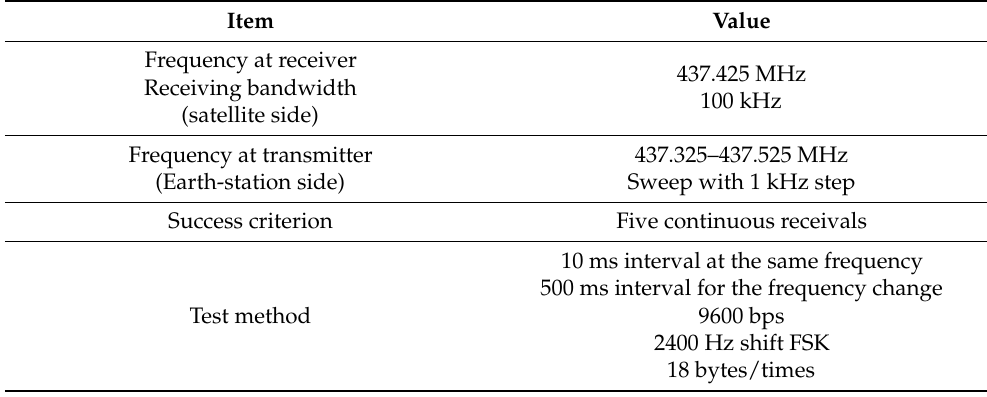
Table 9. Frequency shift tolerance test